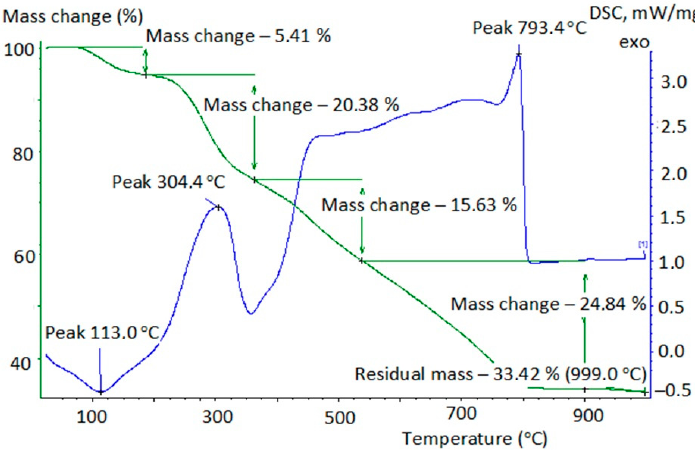
Figure 1. Thermogram of initial iron-containing peat composite.